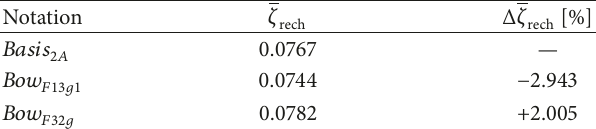
Table 7: Integrated loss coefficient of all investigated vanes.